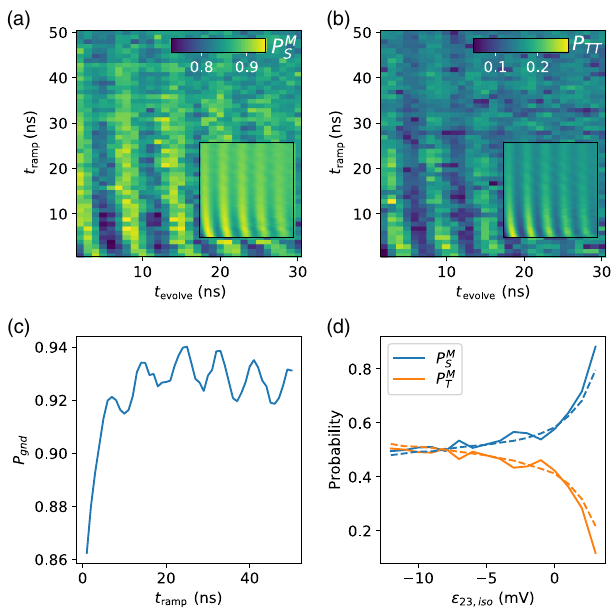
FIG. 4. Adiabaticity of state preparation and readout. (a) Singlet probability for middle-pair readout as a function of ramp-in time and evolution time. (b) Triplet-triplet probability for left- and right-pair readout as a function of ramp-in time and evolution time. Insets in (a) and (b) show numerical simulations of the experiment. (c) Numerical simulation of the overlap, ¼ jh ψ j S ij 2 , between the state at the manipulation stage, P 0 gnd j ψ i , and the low-energy singlet eigenstate j S i , as a function of 0 ramp-in time. The overlap is an indication for the success of the state preparation. (d) Middle-pair singlet and triplet probabilities from experiment (solid lines) and numerical simulations (dashed lines) as a function of middle-pair detuning for the isolation stage after the manipulation. The experimentally obtained prob- abilities are corrected for relaxation during the readout time (see Appendix C